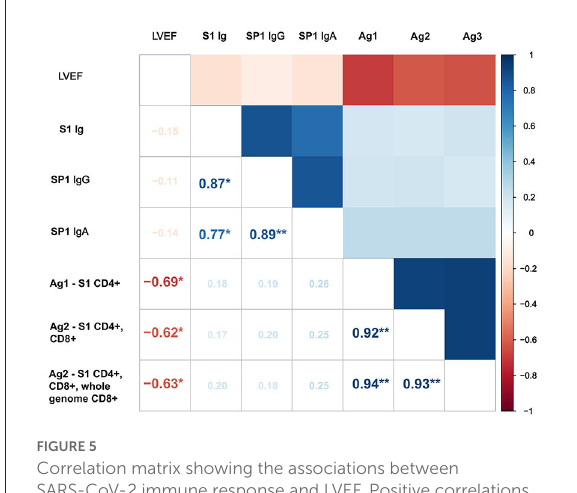
FIGURE5 Correlation matrix showing the associations between SARS-CoV-2 immune response and LVEF. Positive correlations are shown in blue, and negative correlations are shown in red. Ag, Antigen; CD, Cluster of differentiation; SARS-CoV-2, Severe acute respiratory syndrome coronavirus 2; SP1, Spike protein 1; * p < 0.05; ** p <